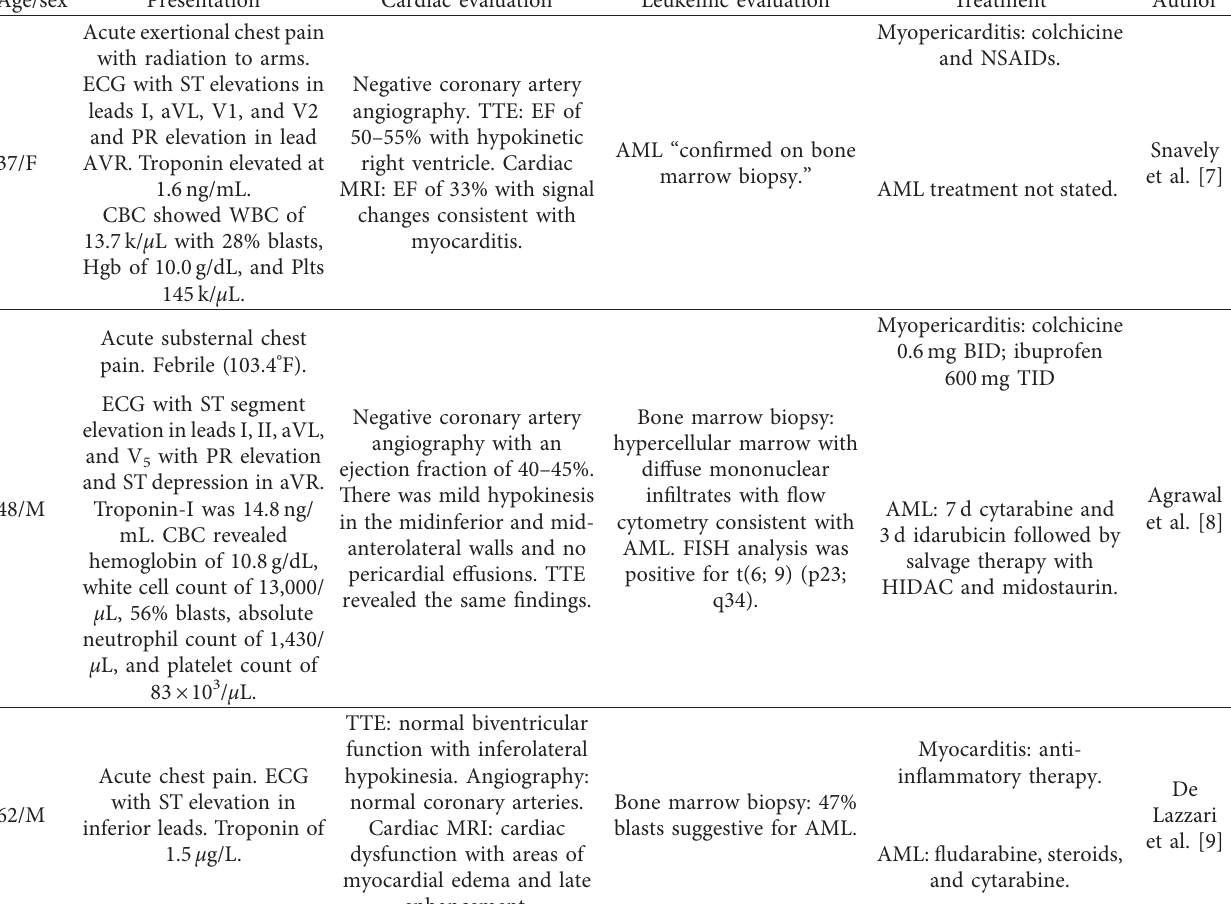
Table 1: Myocarditis/myopericarditis in AML